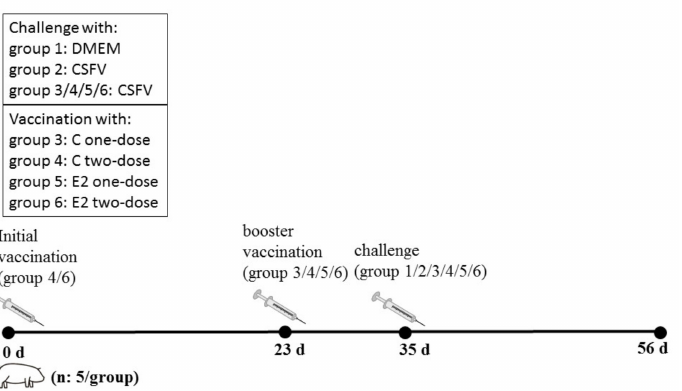
Figure 1. Diagram of the animal experimental design. Piglets received an initial intramuscular injection that was defined as occurring at 0 days post vaccination